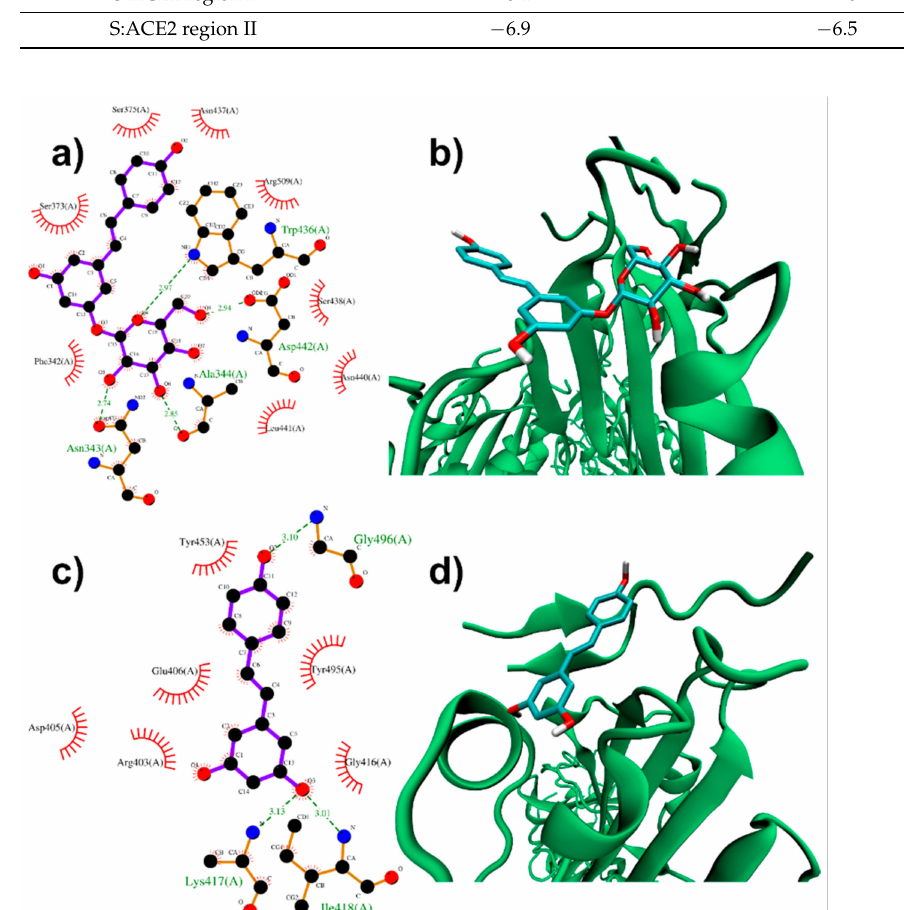
Figure 2. PD ( a , b ) and RESV ( c , d ) top-ranked poses docked to Spike RBD. Two-dimensional interac- tion maps ( a – c ): C, N and O atoms are reported in black, blue and red, respectively. This colour code is adopted also in the following two-dimensional interactions maps. Hydrogen bonds are depicted as green dashed lines, while hydrophobic interactions as red cogwheels. Hydrogen atoms are not depicted for ease of illustration. The names of protein residues involved in interactions with the ligand are reported. Three-dimensional representations of PD and RESV docked poses ( b – d ): Spike backbone is represented as a cartoon, while the ligand as